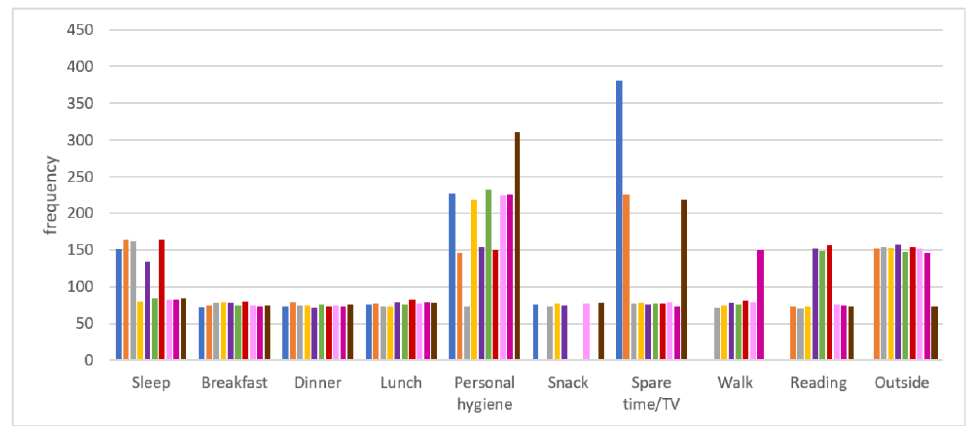
Figure 8. The average duration of each ADL per person. Different colors are used for different per- sons: blue for id = 1, orange for id = 2, gray for id = 3, yellow for id = 4, lilac for id = 5, green for id = 6, red for id = 7, pink for id = 8, fuchsia for id = 9, brown for id = 10.